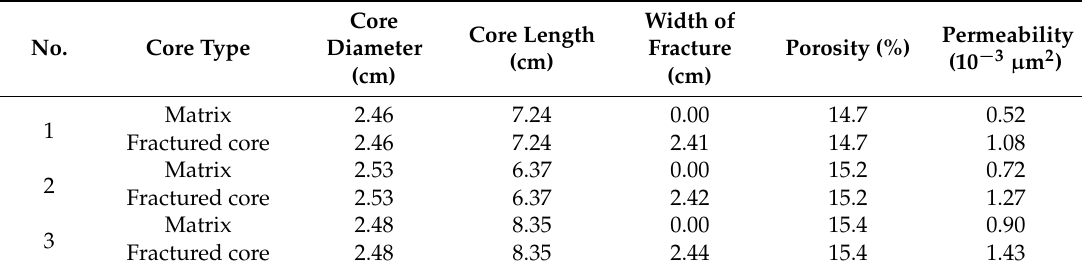
Table 1. Physical parameters of the matrix and fractured Table 1 . Physical parameters of the matrix and fractured cores.